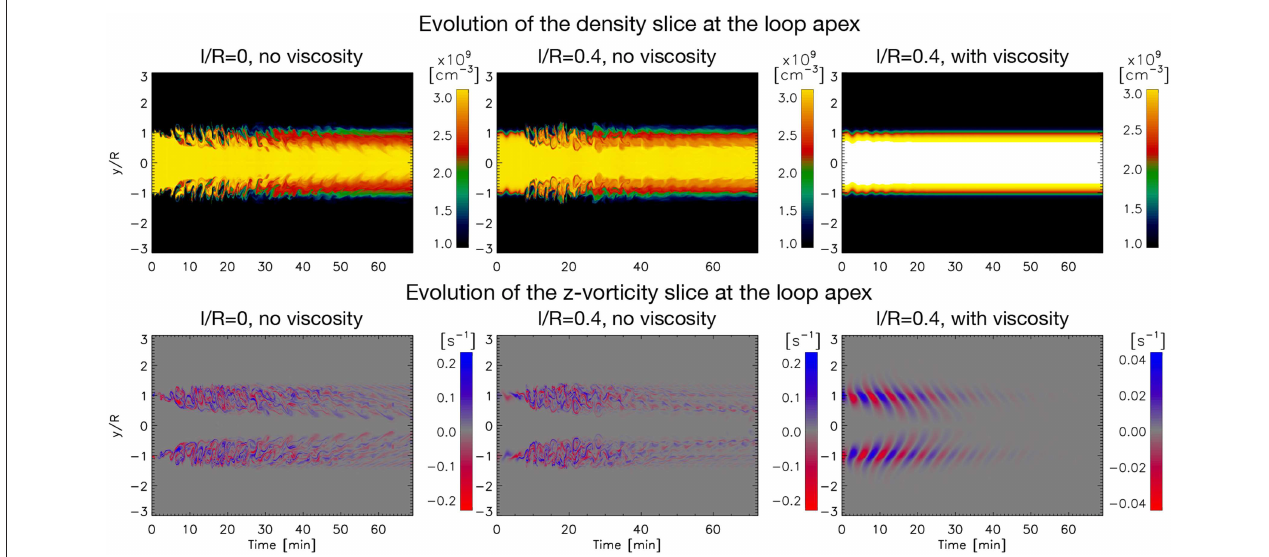
FIGURE 5 | Outward and inward expansion of the vortices. For each loop model we take a parallel cut to the y axis across the loop passing through its center at each time step (see text for details on the procedure) and plot the resulting time-distance maps of the density (top panels) and z right the columns correspond, respectively, to the model with no initial boundary layer and no viscosity, the model with initial boundary layer and no viscosity, and the model with initial boundary layer and viscosity. Note that the time range in the simulation with initial boundary layer and viscosity is slightly more extended in order to better visualize the inner vortices reaching the core of the loop. Note also that the extrema for the z